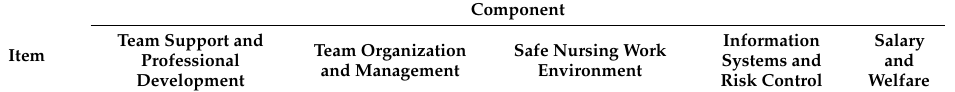
Table 1. Components of the IQN-WE-PT